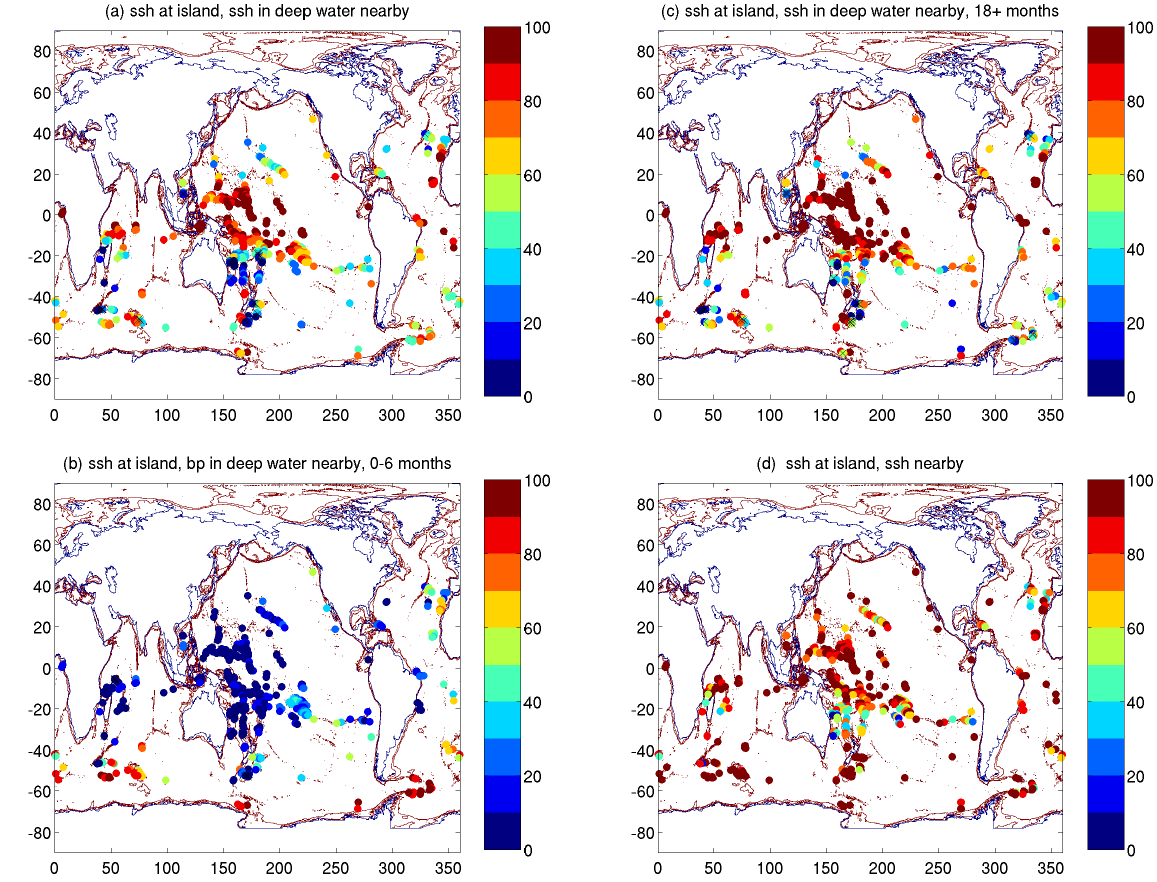
Fig. 3. Percentage of variance of h at island explained by h (a, c, d) or p (b) in a neighbouring ring of water 3000m deep (a–c) or 500–1000m (d) . (b) and (c) have 0–6 month high-pass and 18+ month low-pass filters applied respectively; (a) and (d) are